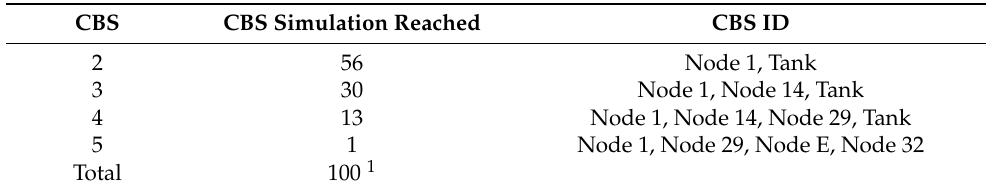
Table 1. Number of CBS distribution and frequency proposed by GA technique, (Statistical GA Location at Case 1).